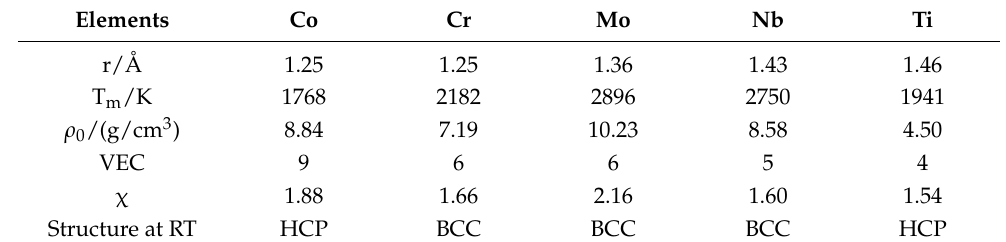
Table 1. Structure and properties of RHEA elements.